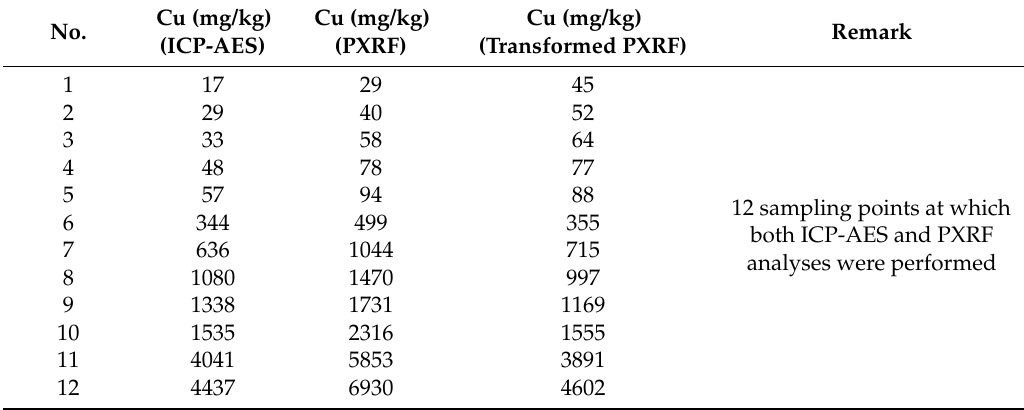
Table 1. Copper concentration results determined using ICP-AES and PXRF for 12 sampling